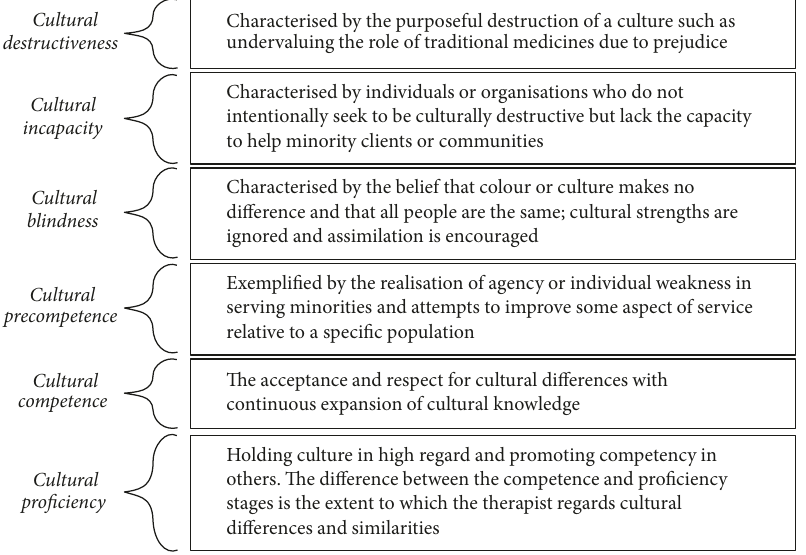
Figure 1: Cultural competence continuum [12,